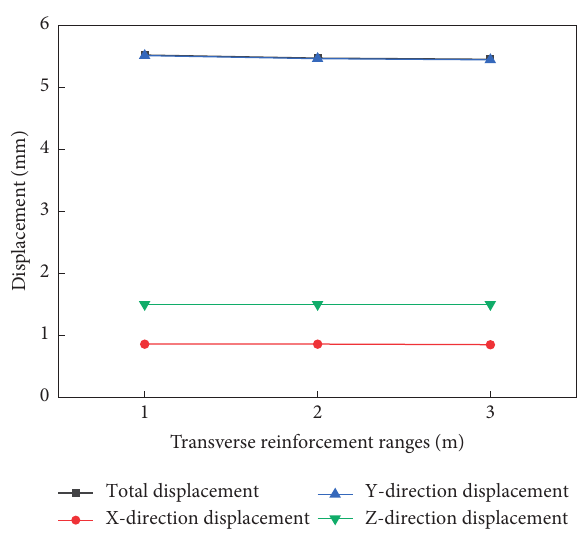
Figure 8: Displacement under transverse reinforcing ranges of 1m, 2 m, and